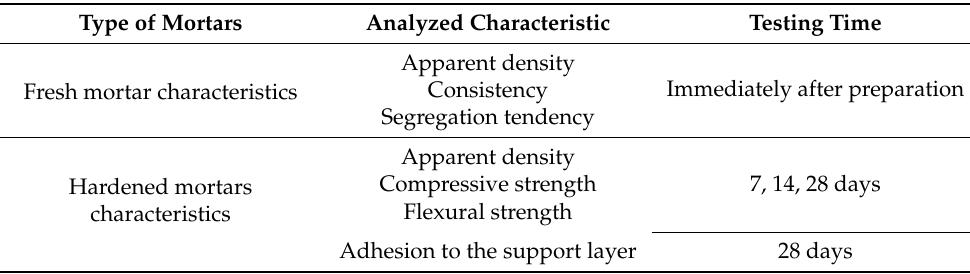
Table 4. Analyzed characteristics of fresh and hardened state